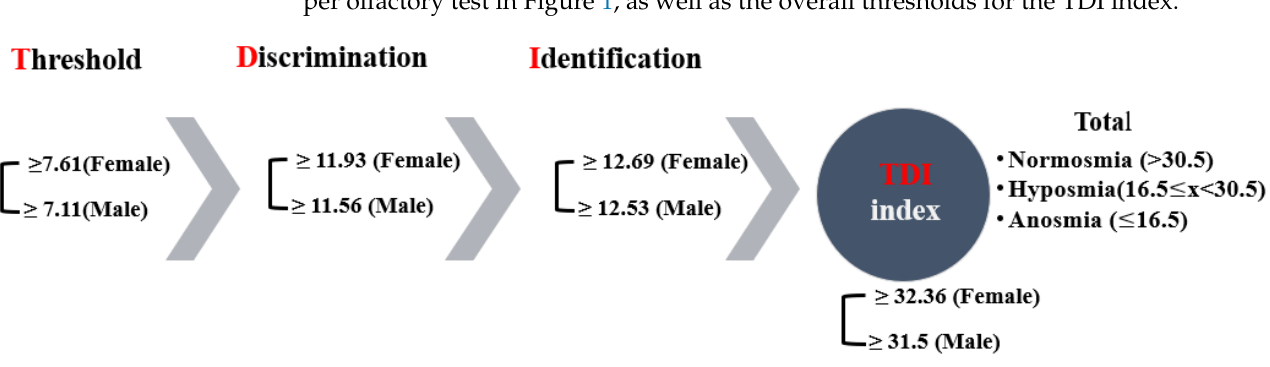
Figure 1. The olfactory psychophysiological testing process and respective norms. Procedure